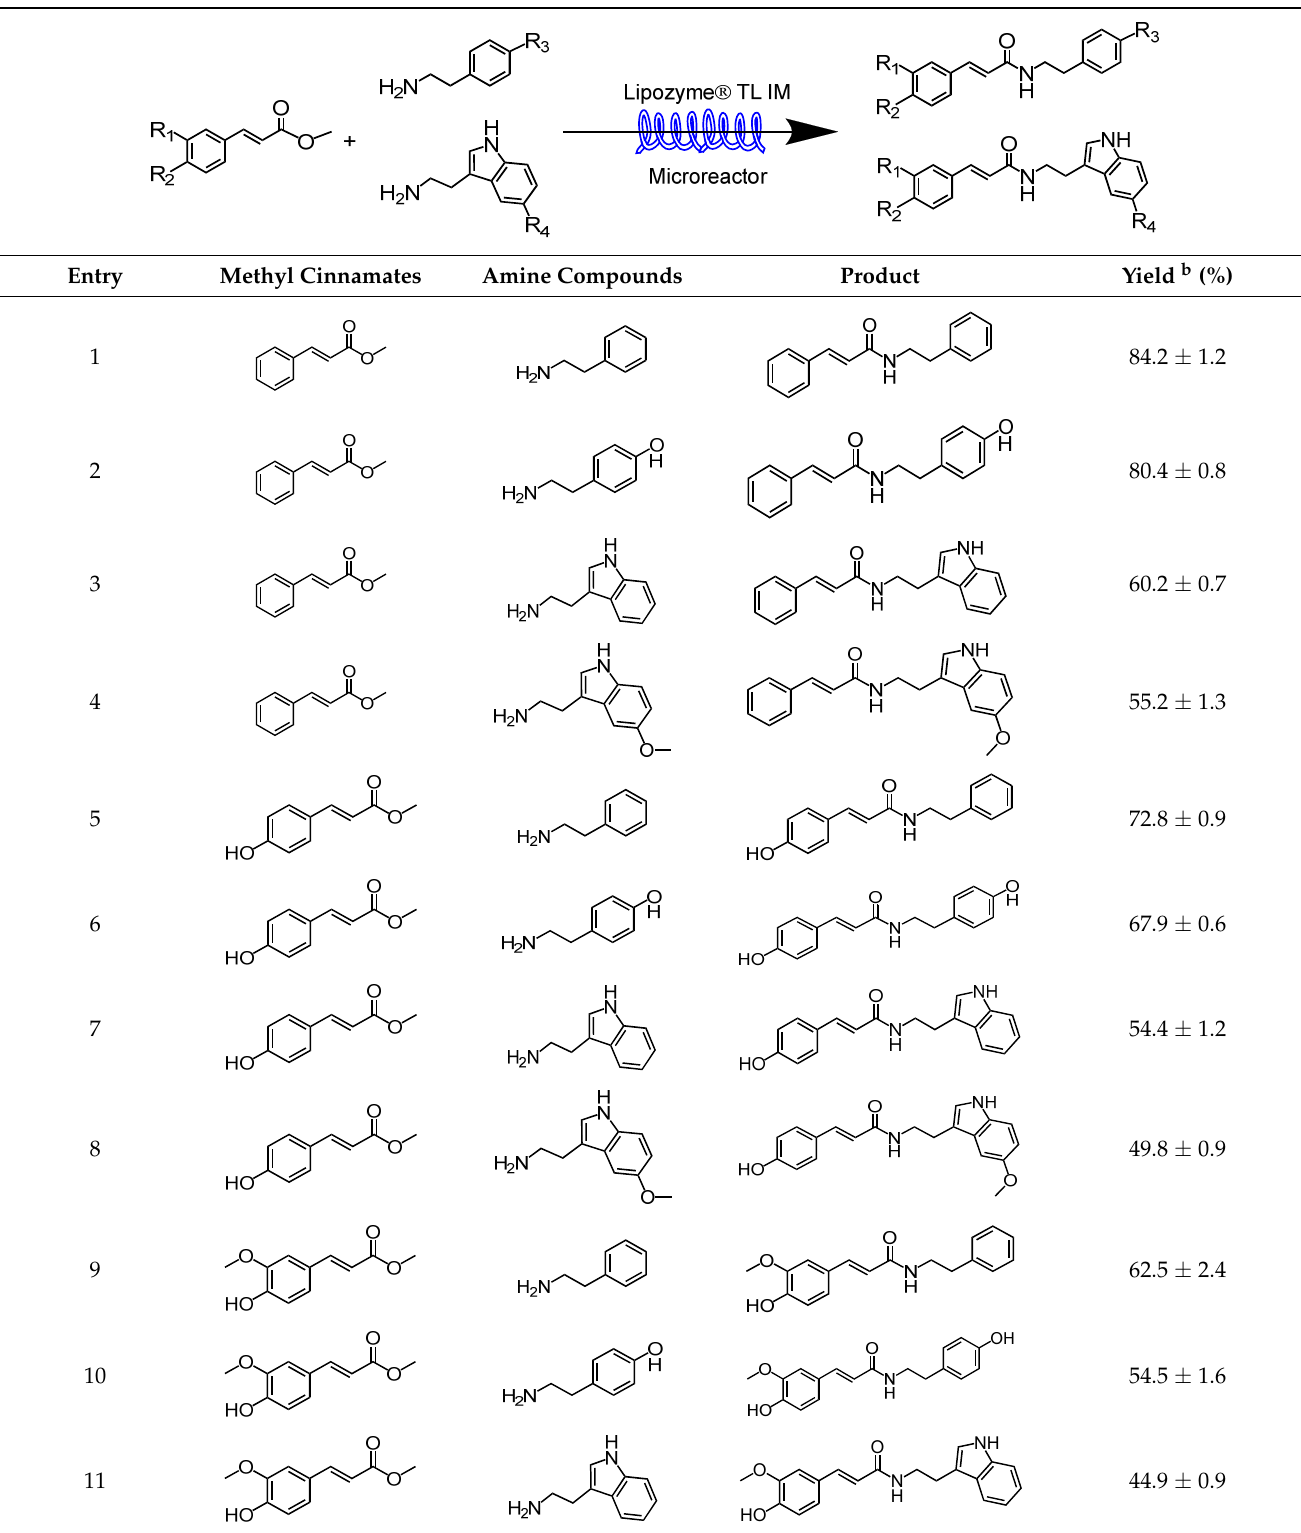
Table 3. Effect of substrate structure on the synthesis of cinnamamide derivatives catalyzed by Lipozyme ® TL IM in continuous-flow microreactors a .